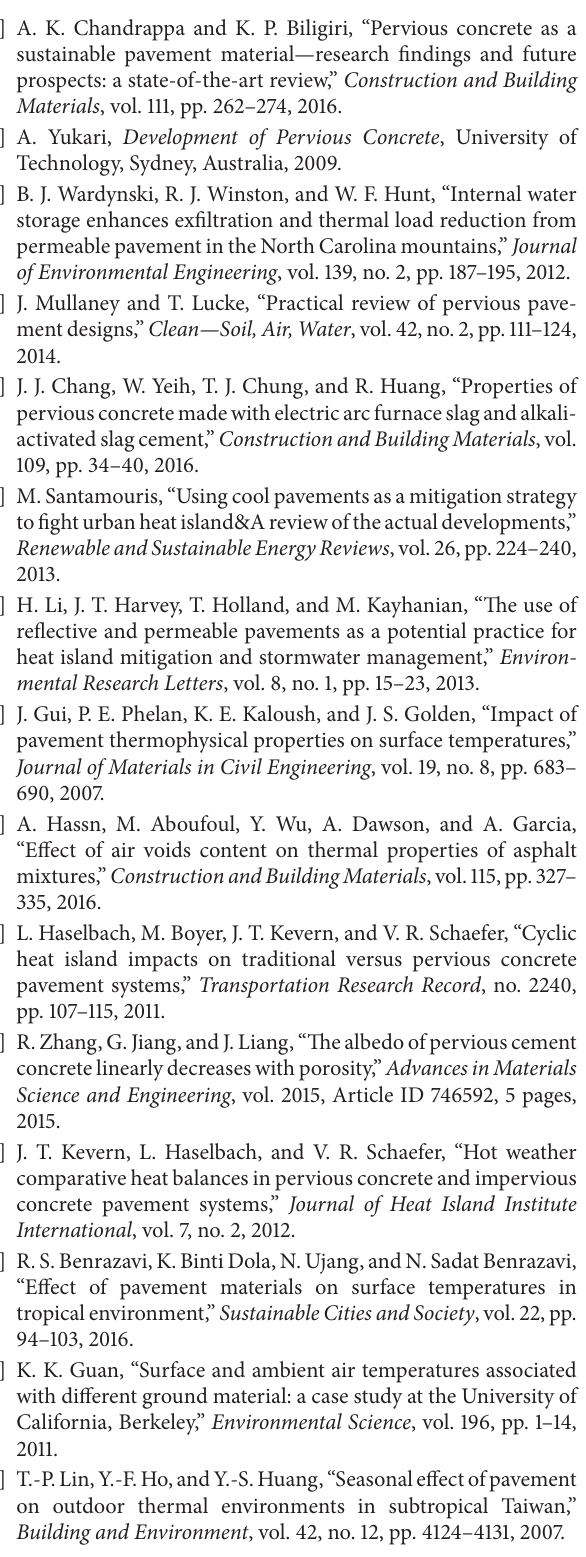
Figure 11: Total output heat flux of surface of different concrete during 48 h in June 2016.